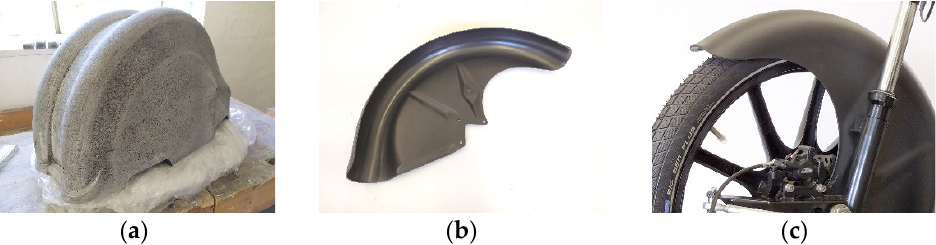
Figure 15. ( a ) Binder-jetted sand mold for thermoforming thermoplastic fenders, ( b ) thermoformed fender made from ABS, ( c ) application of the ABS fender.